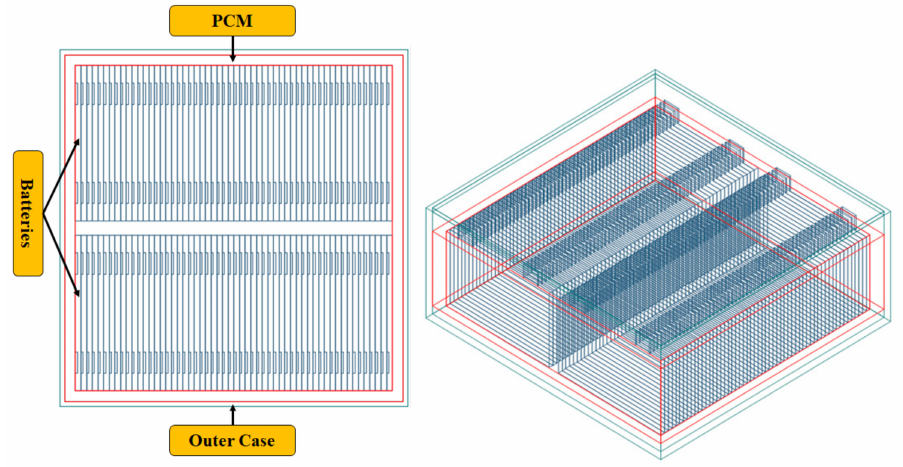
Figure 5. Design of the 6-kW Li polymer battery